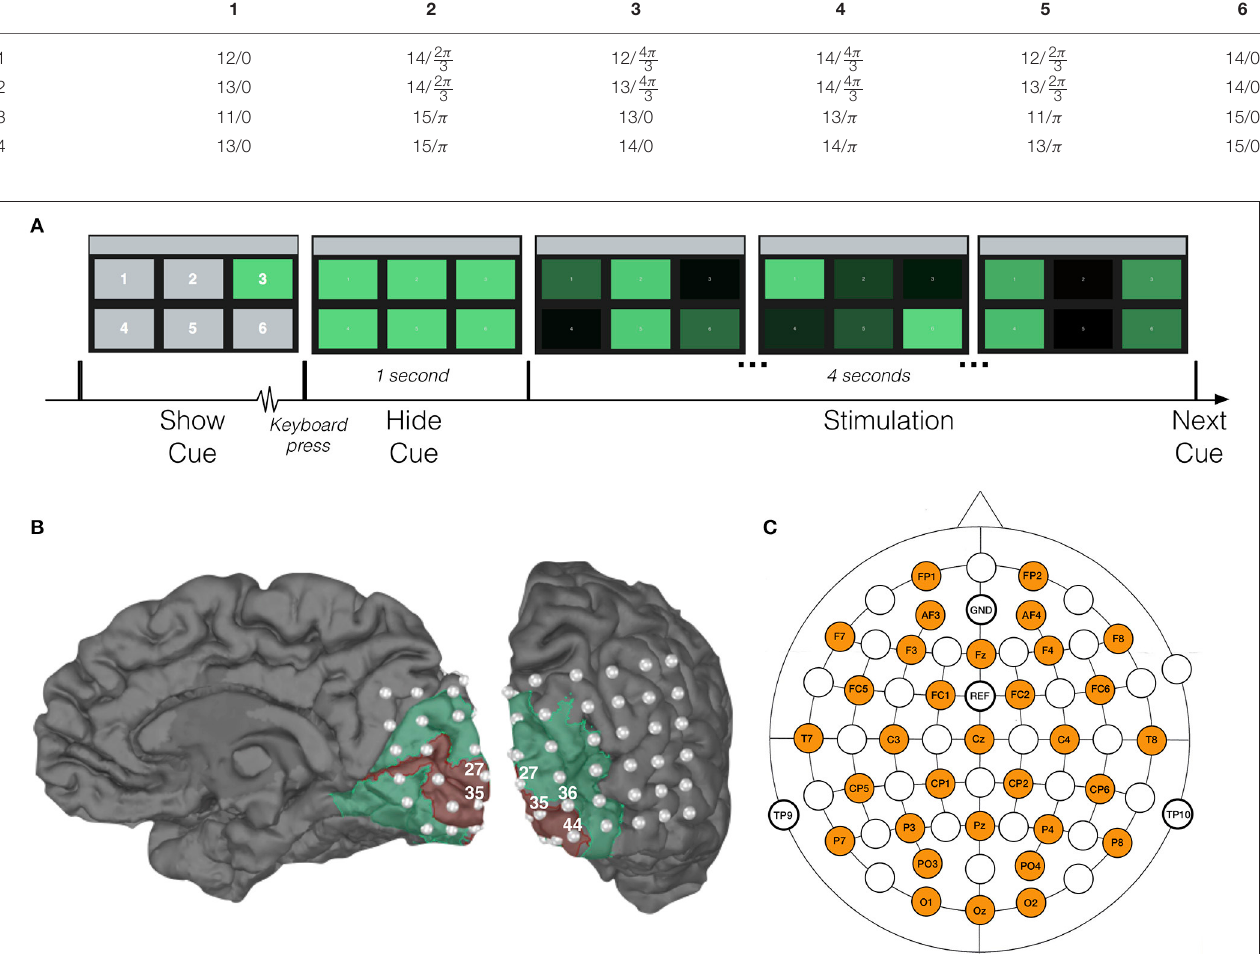
TABLE 1 | Target frequency-phase combinations for each session, represented as [frequency (Hz)/phase (radians)]. Session